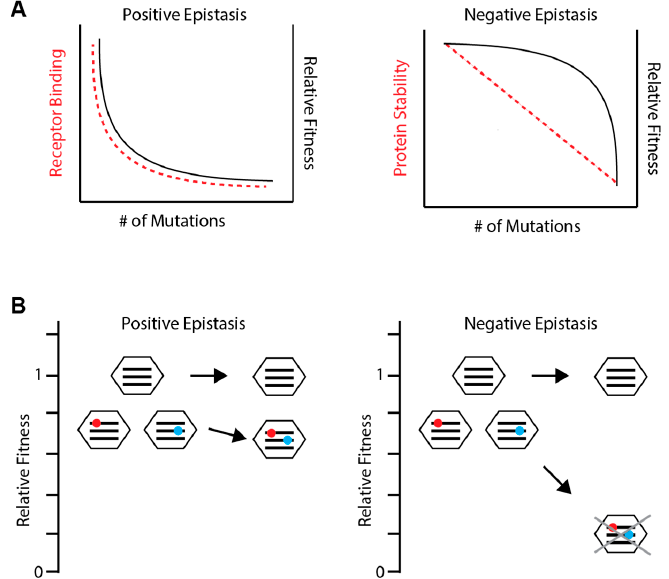
Figure 2. Patterns of epistasis. ( A ) Distinct epistatic patterns are predicted based on how phenotypic effects (red dashed lines) correspond to fitness effects (black solid lines). Small genomes may encode